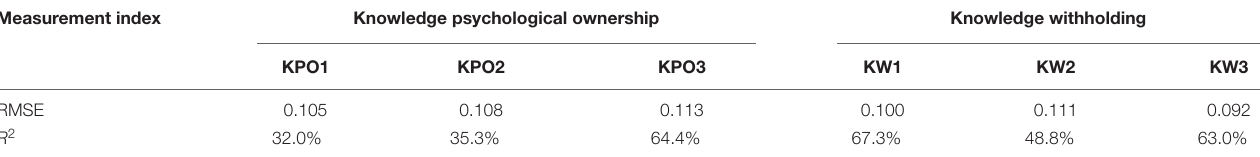
FIGURE 4 | Structural equation method-artificial neural network structure. TABLE 5 | Structural equation method-artificial neural network (SEM-ANN) evaluation index of knowledge withholding. Measurement